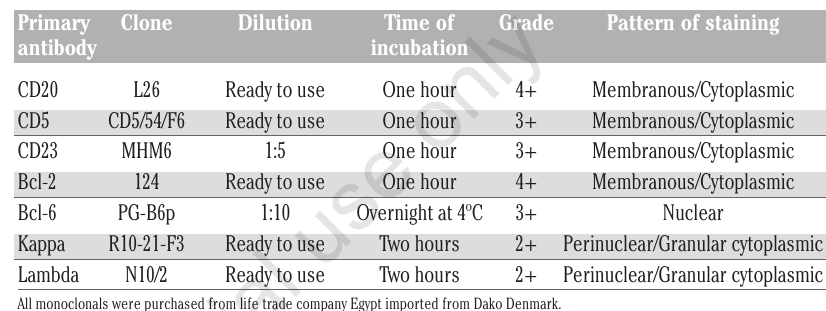
Table 1. Monoclonal antibodies.